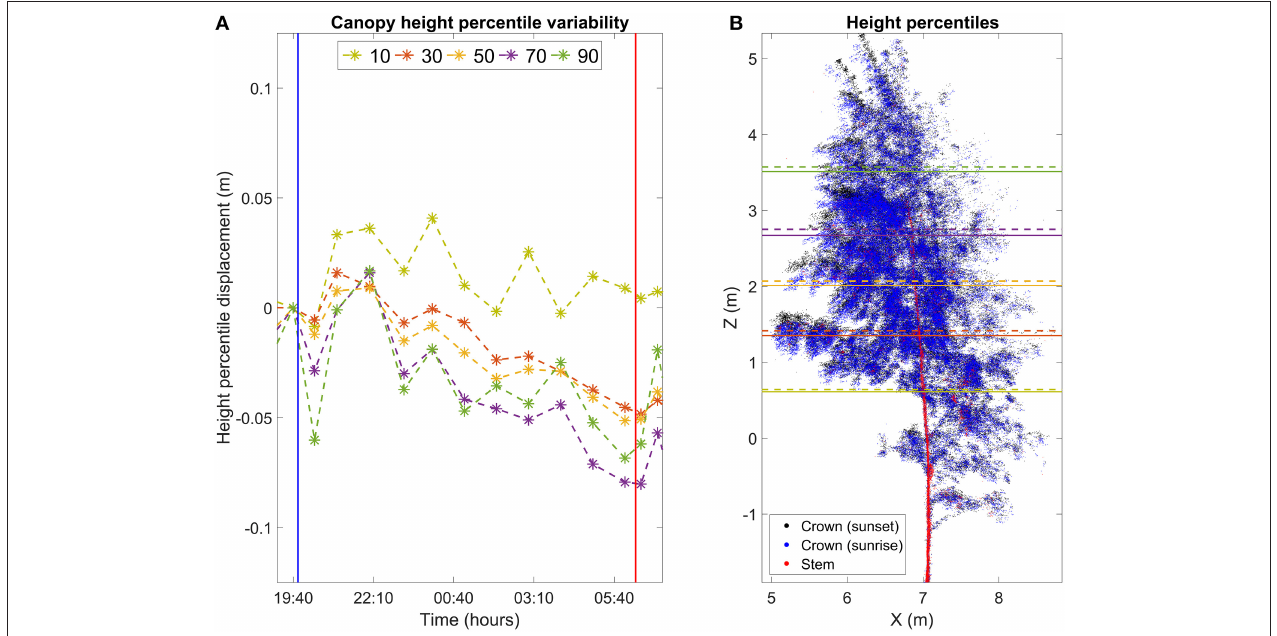
FIGURE 3 | (A) Movement of height percentiles of birch crown points in the Finnish dataset. Height and time are reported with respect to the scan closest to sunset. Vertical lines mark sunset (blue) and sunrise (red). (B) Maximum movement of height percentile positions overnight. Black points represent the birch crown at sunset. Blue points represent the birch crown at the time of sunrise. Red points represent the birch stem and the thickest branches. The stem and crown points were differentiated with NDVI thresholding. Horizontal lines represent the height percentile locations at sunset (dashed, about 19:40 o’clock) and in morning (solid, 06:40 o’clock).